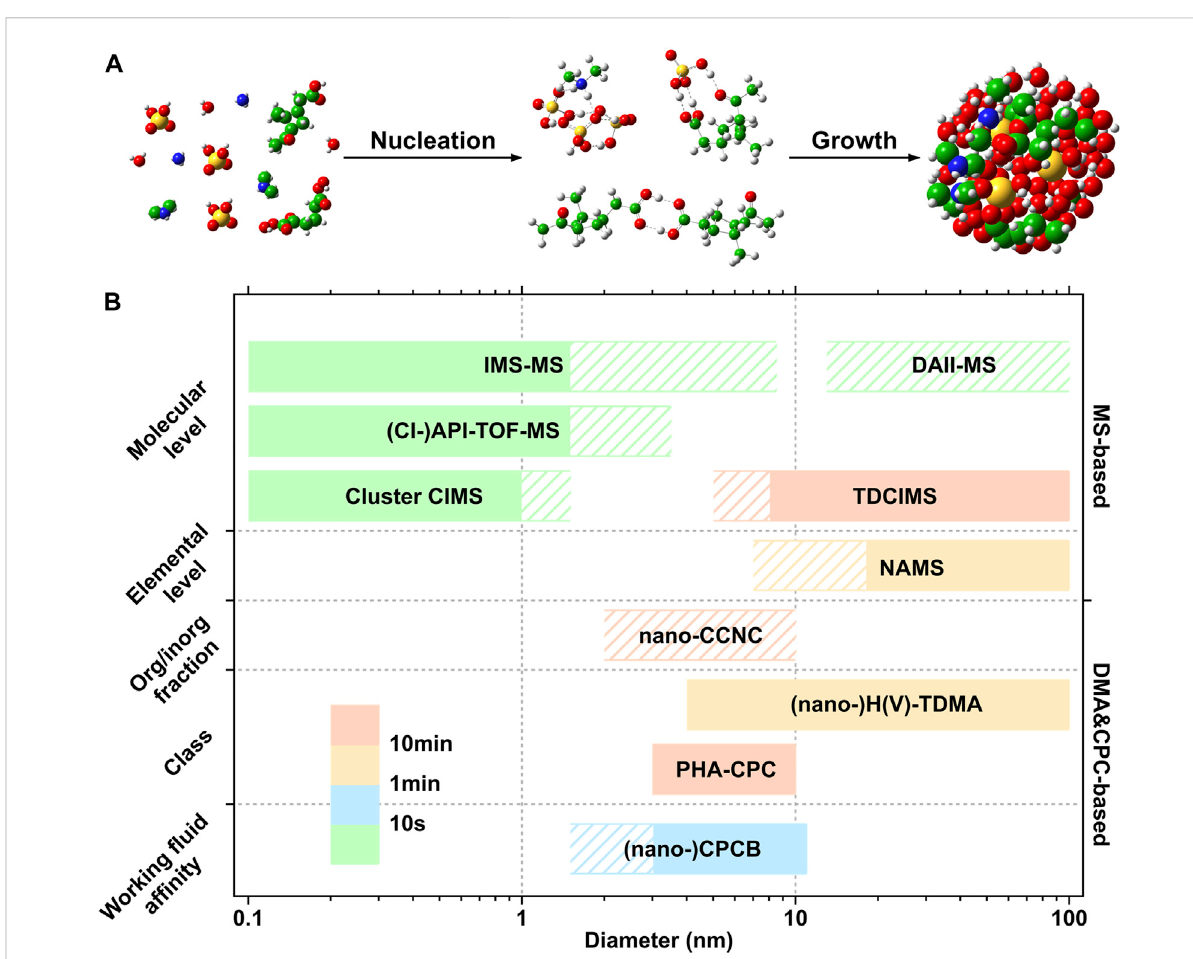
FIGURE 1 (A) Schematicofnanoparticleformationandgrowth. (B) Overviewofthetechniquesthatcanretrievechemicalinformationofnanoclustersand ultra fi neparticles(Thetechniquesthat havenotbeen applied forparticlesinthesub-20 nmdiameter range arenotincluded).The fi llcolorsfor each technique are used to show the time resolution. The shaded area by gridlines indicates the diameter range in which the techniques have not been applied in fi eld measurement. Technique abbreviations are listed in Appendix